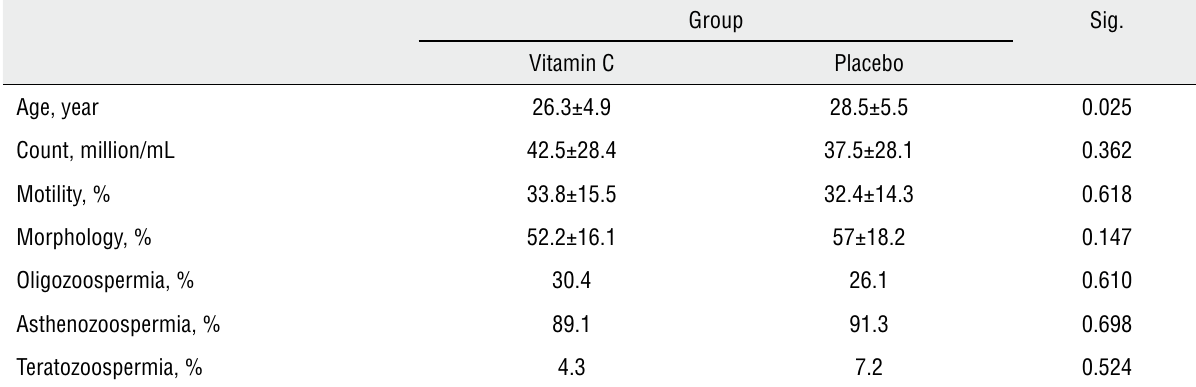
Table 1 - Basic characteristics of the intervention and placebo groups before treatment*